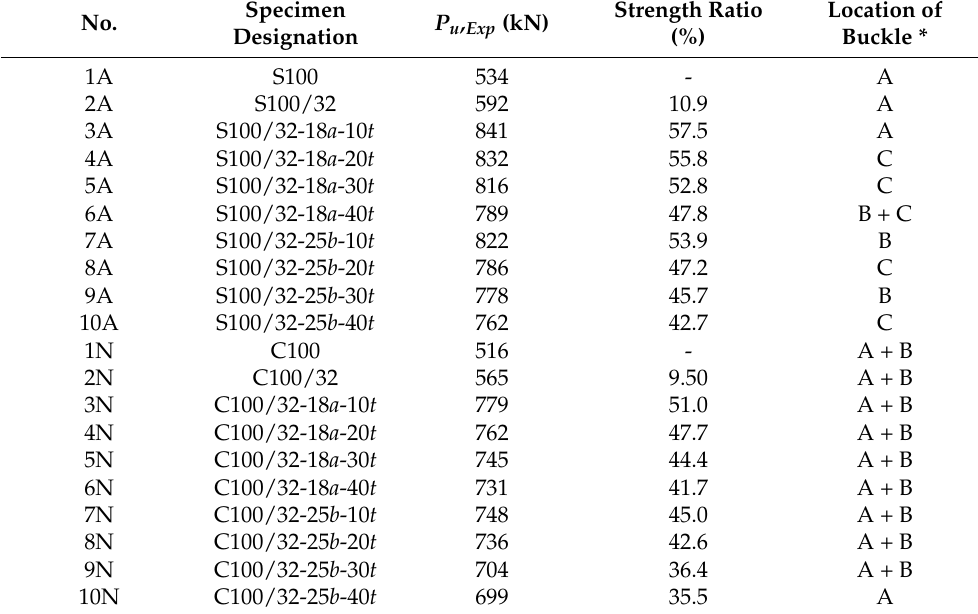
Location of Buckle * = A: Elephant foot buckling. B: Mid-height local buckling. C: Quarter-height local buckling.